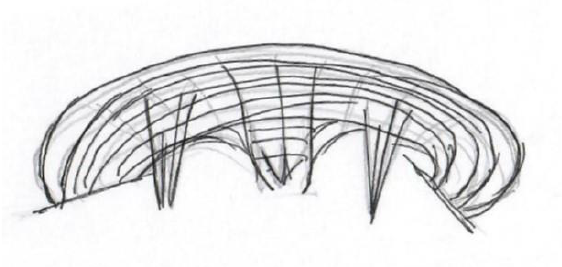
Fig. 7 First design sketch of the entrance portal “Wings”.